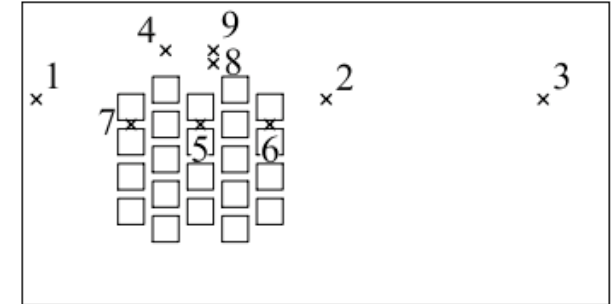
Fig.11. Positions of measurement points with Dopller ve- locimeter